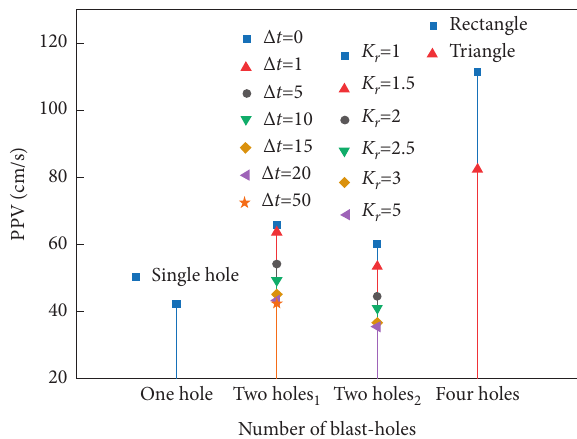
Figure 18: PPVs with different